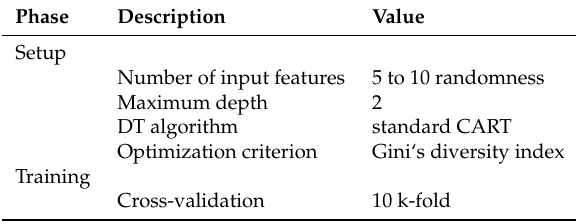
Table 10. DT configuration.